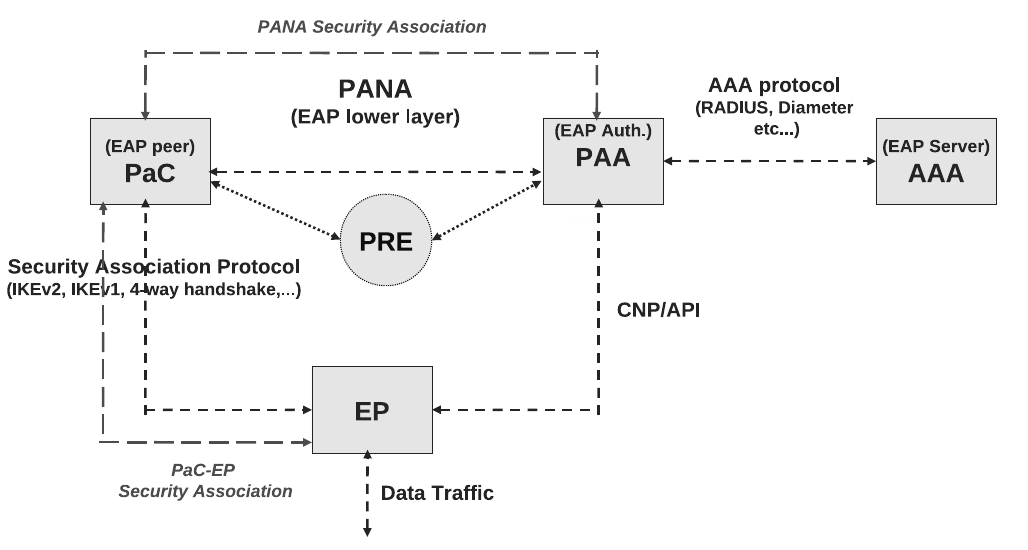
Figure 3. Protocol for Carrying Authentication for Network Access (PANA)